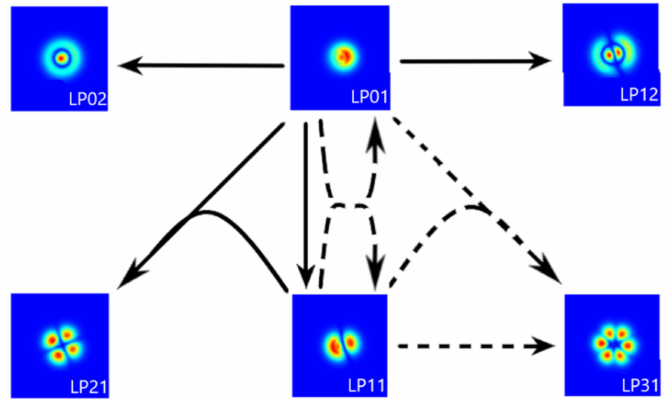
Figure 2. A simplified map of the theoretical four-wave mixing mode-generation path represents the theoretical LP xx modes distributions in fiber with a 30 mm bending radius. A single arrow represents a degenerated four-wave mixing process, where both pumping beams have the same modal structure. Solid/dashed lines represent transitions with conserved/mixed polarization states, respectively. The second generated beam (not shown) has the same modal structure as one of the pump